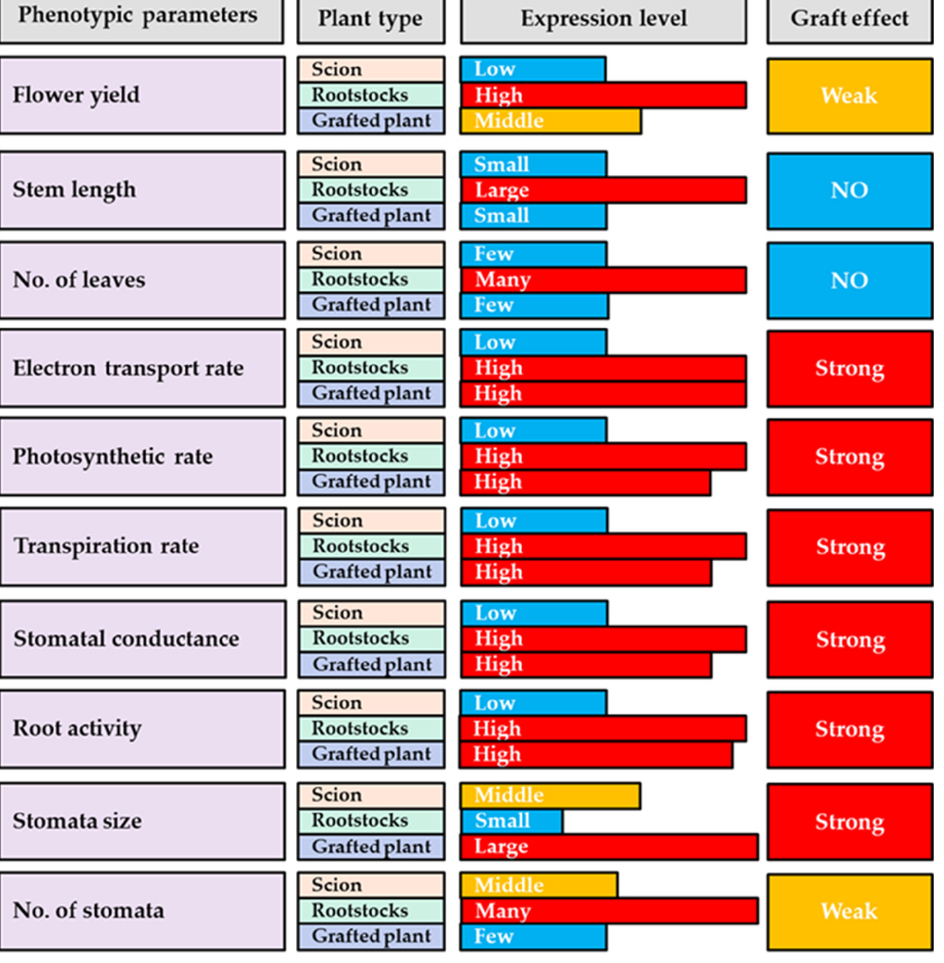
Figure 9. A summary of the phenotypical expression characteristics and grafting effects of the scion, rootstocks, and grafted cut rose flowers grown in the greenhouse during the summer season.